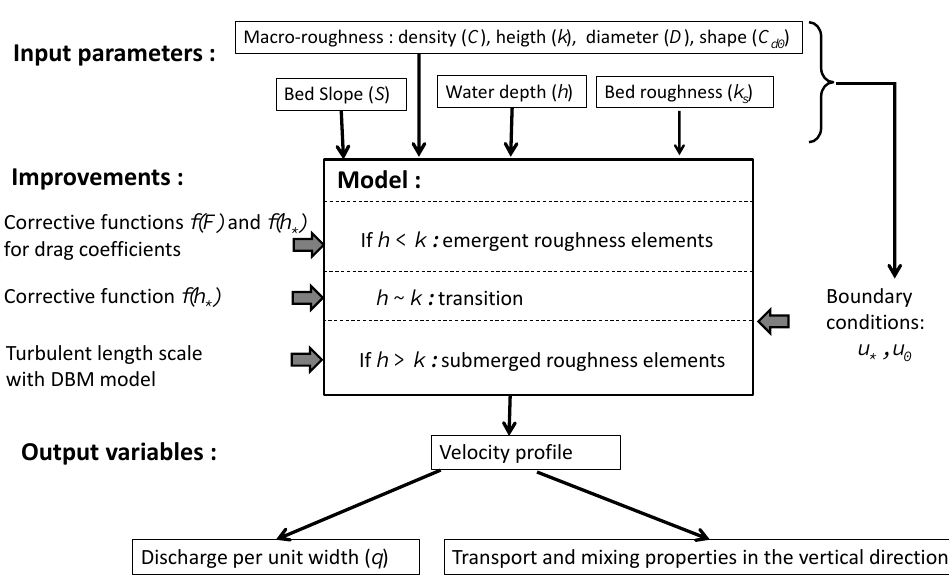
Figure 1. Definition sketch of the input, output, and improvements of the model. S is the bed slope and k s the bed roughness heigth.